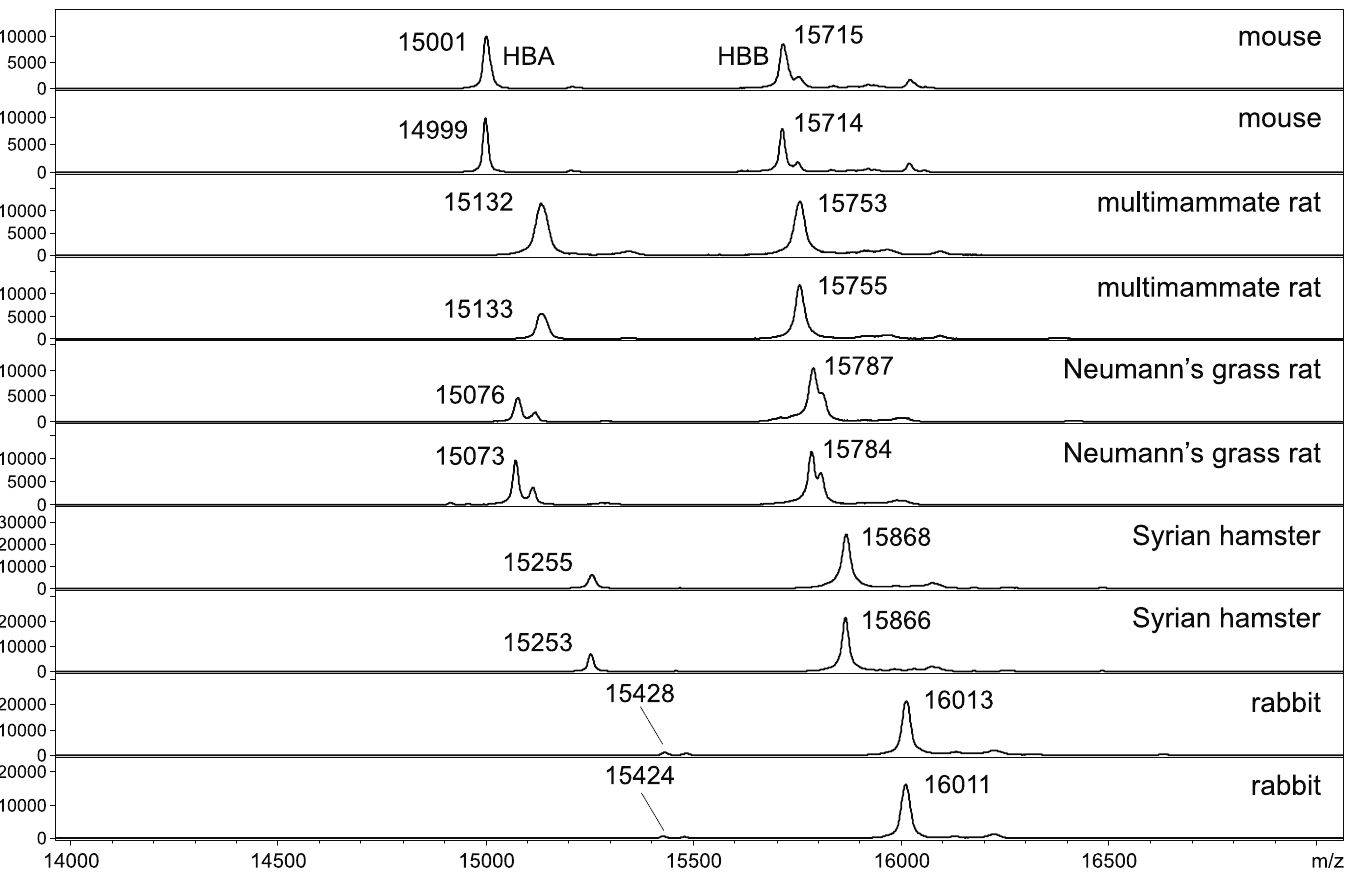
Fig 1. MALDI-TOF protein profiles of homogenized female abdomens of P . perniciosus bloodfed on five different hosts 12 h after feeding. Peaks of host hemoglobin subunit alpha (HBA; about 15 kDa) and hemoglobin subunit beta (HBB; about 16 kDa) dominated in the spectra. For each host the spectra of two females are presented.